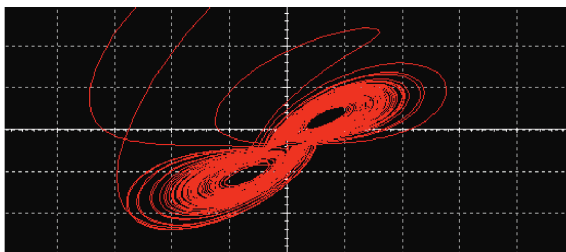
Figure 13: ( x, y ) space portrait of the Multisim simulation of equations